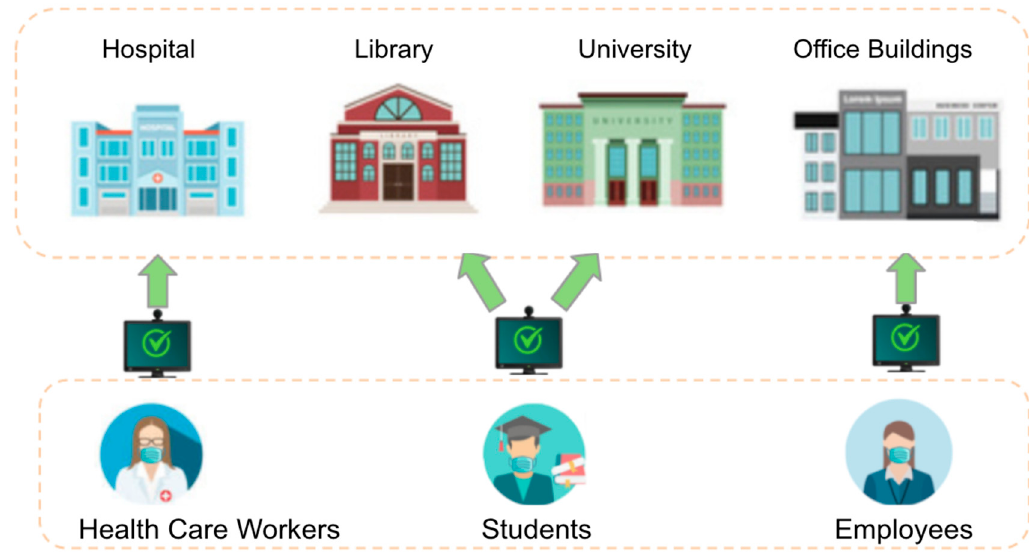
Figure 18. Use Cases of Spartan System.